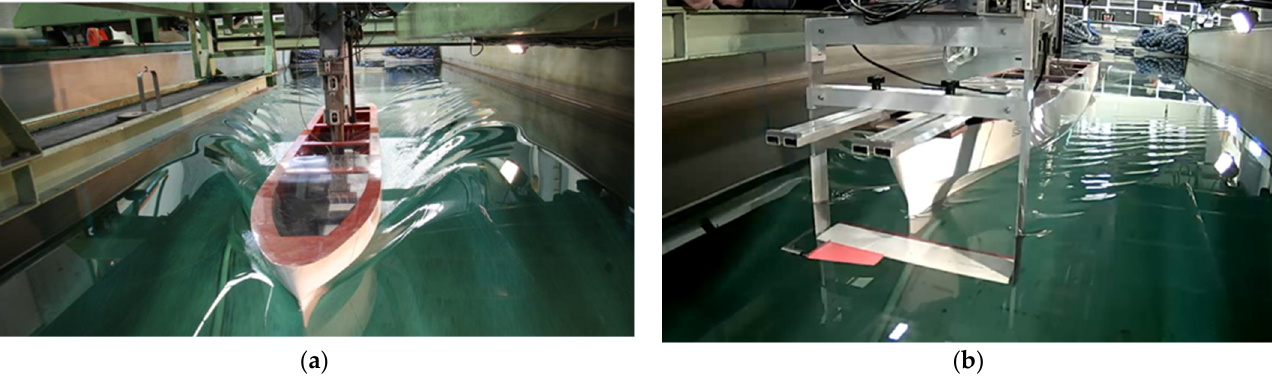
Figure 6. Tank tests of the hull model in waves: ( a ) without the dynamic wing and ( b ) with the flapping thruster, and determination of motions and total resistance.